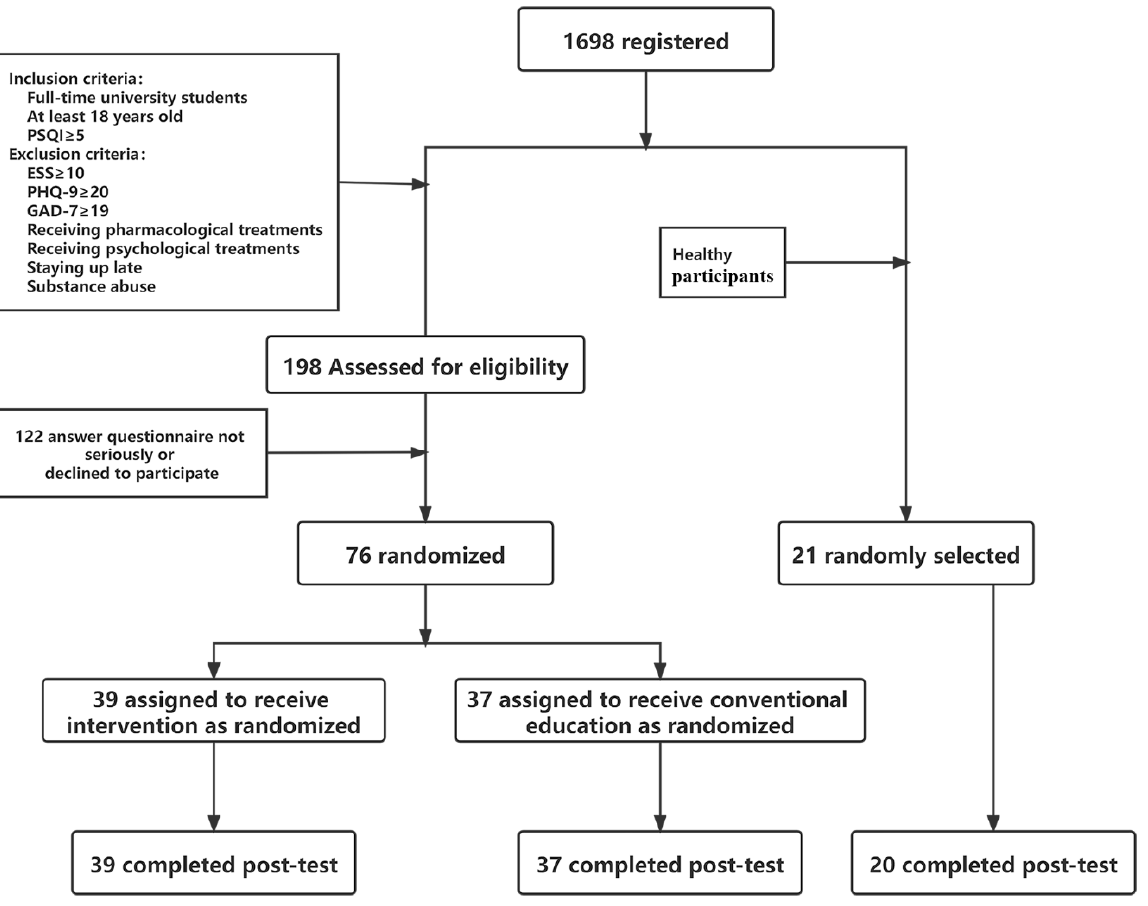
Figure 1. CONSORT flow diagram.